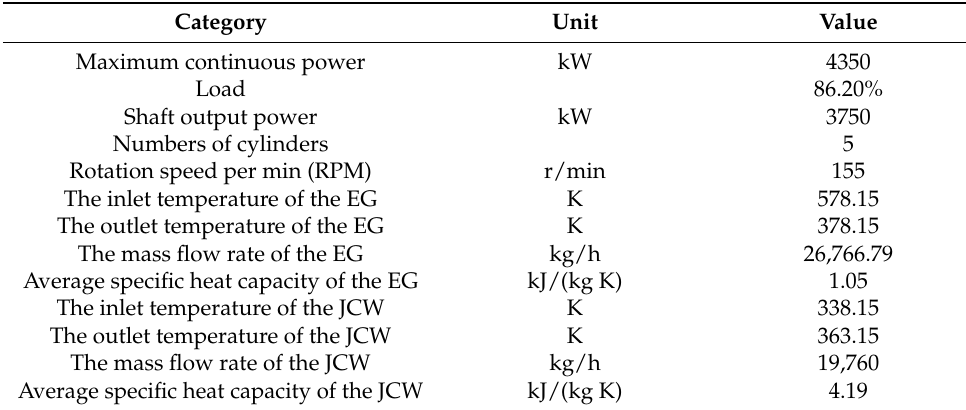
Figure 1. Physical picture of Wartsilas5rt-flex35. Table 1. The recorded operating parameters of WARTSILA 5RT-flex35.